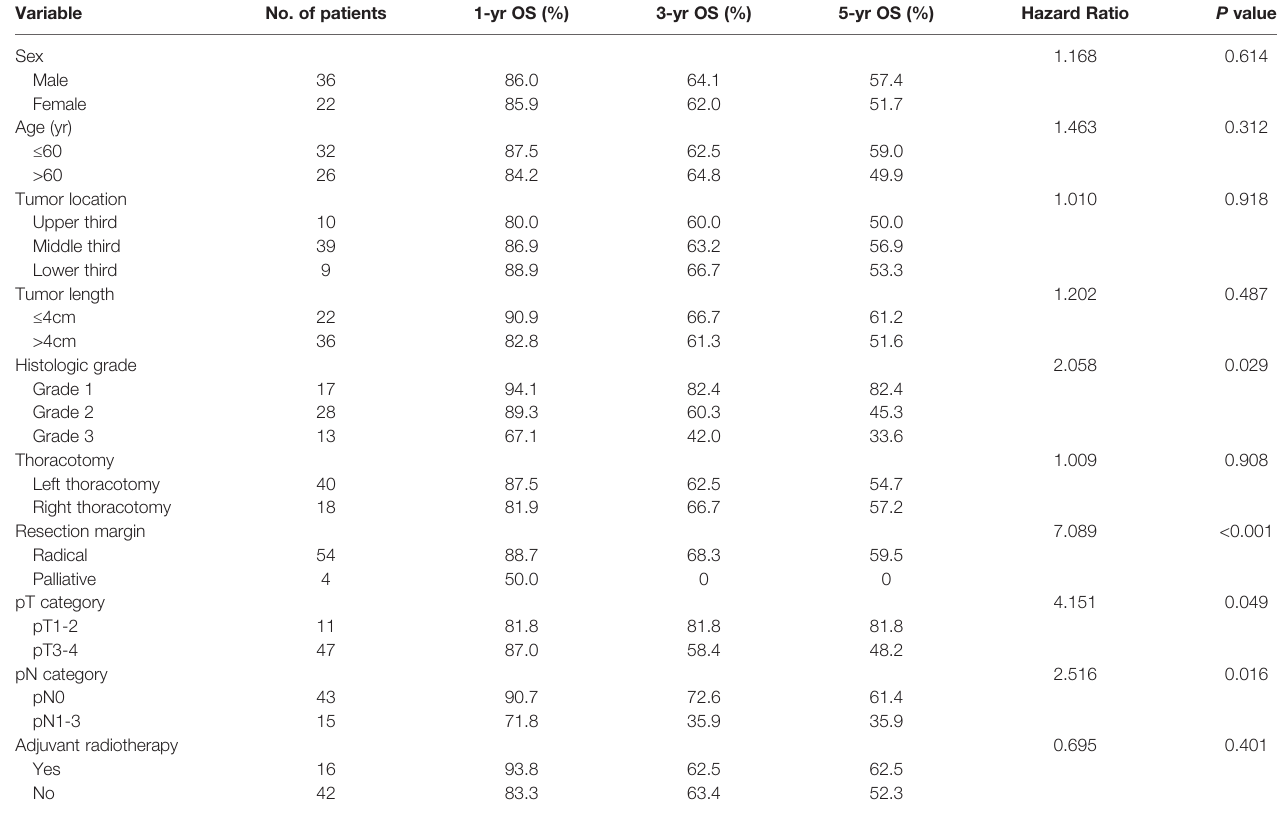
TABLE 3 | Univariate analysis in regard to overall survival according to clinicopathological features for 58 patients with EMEC.